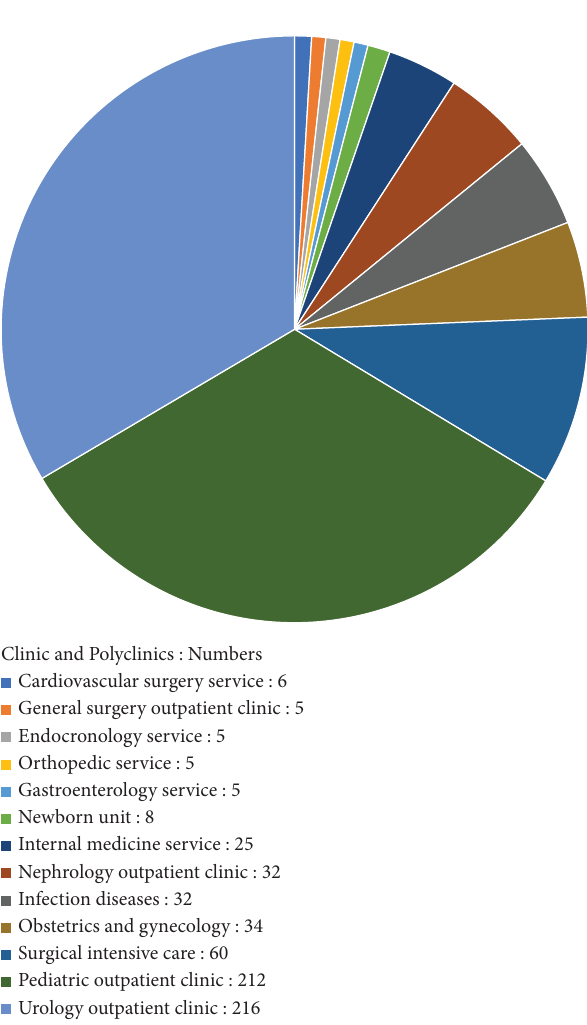
Figure 2: Te distribution of 645 patients by clinics and